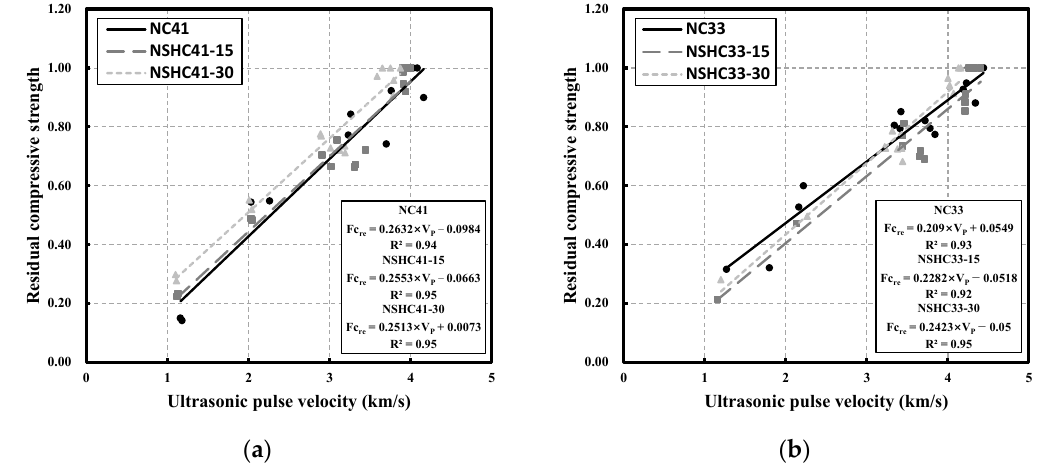
Figure 11. Correlation between residual compressive strength and ultrasonic pulse velocity in NC and NSHC after high ‐ temperature exposure: ( a ) W/B 41; ( b ) W/B 33.